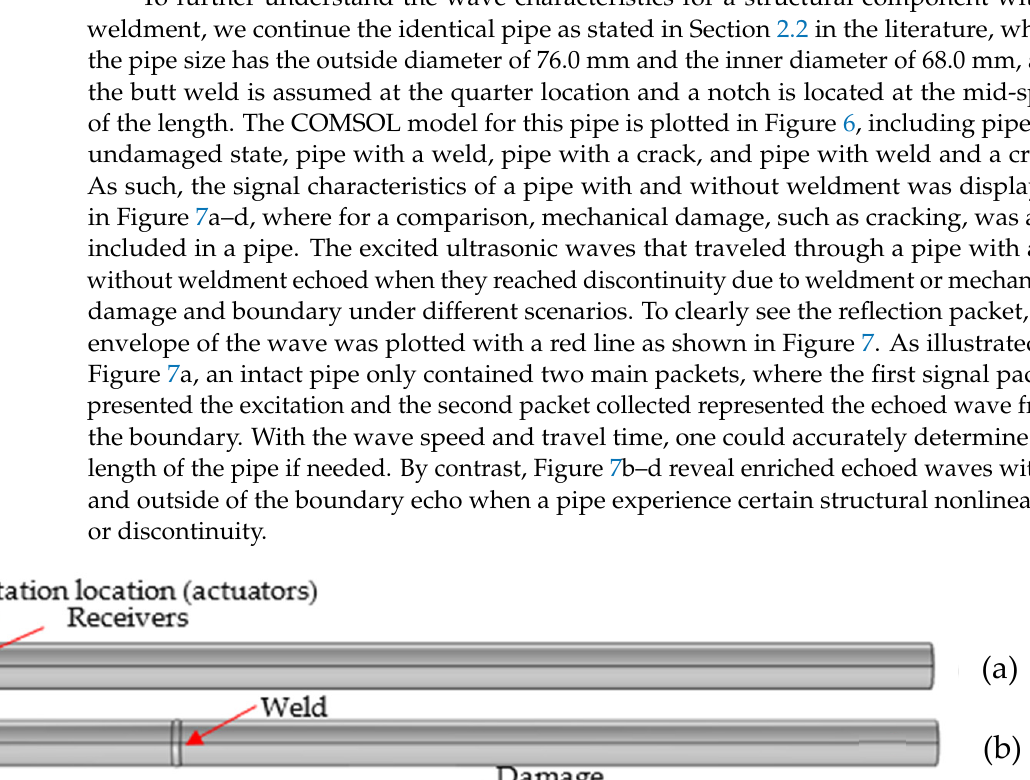
Figure 7. Signal characteristics of the pipes under varying cases: ( a )–( d ). 3. Deep Learning-Based Damage Diagnostics 3.1. Framework of the Deep Learning for Damage Diagnostics The convolutional neural network was employed to decode guided wave signals to identify potential damages experienced in a pipe. As illustrated in Figure 8, the learning framework consisted of three main parts, including dataset collected by the simulation and data augmenting method, training CNN models by training set and modifying by validation set, and predicting the testing data formed by CNN models. Specifically, the guided wave dataset simulated by the finite element method was enlarged by adding Gaussian white noise with different SNRs. The classification label was defined by the state